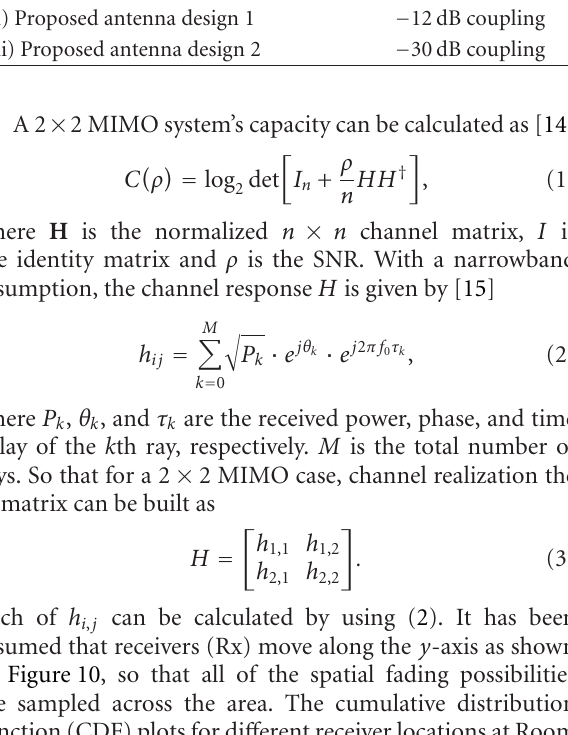
Table 2: Mutual coupling levels of the antennas. Antenna Types for FAP Mutual coupling